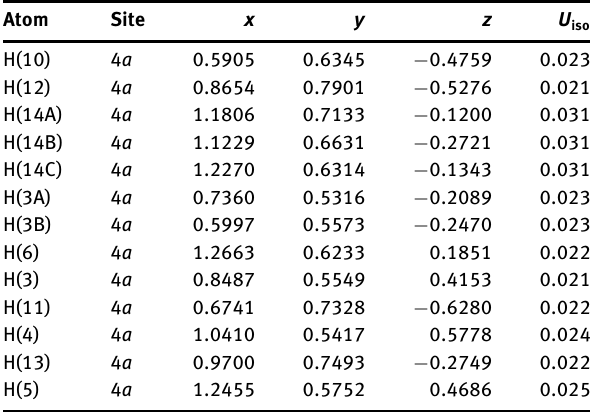
Table 2: Fractional atomic coordinates and isotropic or equivalent isotropic displacement parameters (Å 2